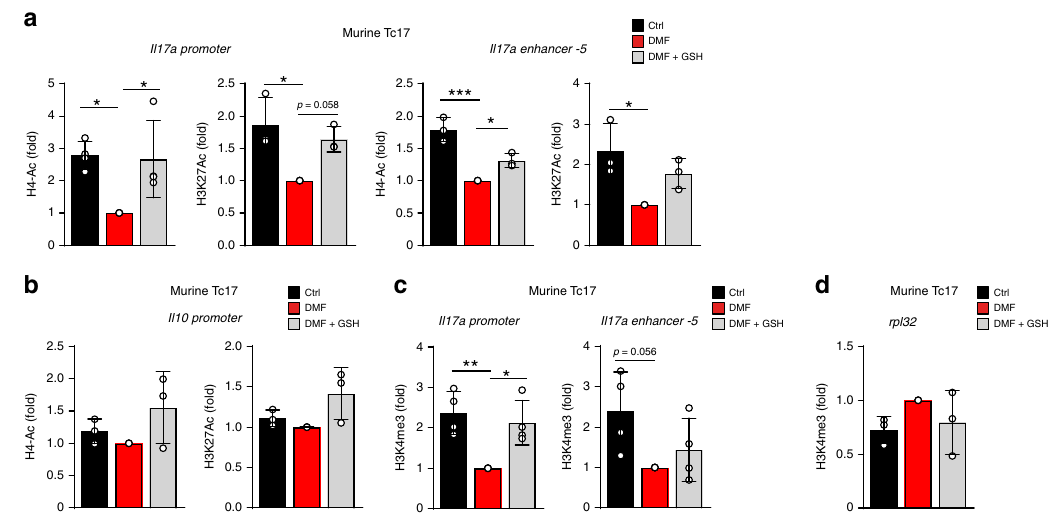
Fig. 5 Suppression of histone modi fi cations on Il17a promoter by DMF is GSH-dependent. a ChIP assays for H4Ac and H3K27Ac at the Il17a promoter, Il17 enhancer-5 in murine Tc17 cells differentiated for 72 h ± DMF or DMF + GSH. b ChIP assays for H4Ac and H3K27Ac at the Il10 promoter in murine Tc17 cells differentiated for 72 h ± DMF or DMF + GSH. c ChIP assays for H3K4me3 at the Il17 promoter, Il17 enhancer-5 in murine Tc17 cells differentiated for 72 h ± DMF or DMF + GSH. d ChIP assays for H3K4me3 at the Rpl32 promoter in murine Tc17 cells differentiated for 72 h ± DMF or DMF + GSH. Bars show mean ± s.d. of fold change normalized to DMF treatment, which was arbitrarily set to 1. Data from three a – d combined experiments; individual values are plotted. In a – d , * p < 0.05, ** p < 0.01, *** p < 0.001, evaluated by one-way ANOVA followed by Tukey ’ s HSD multiple comparison